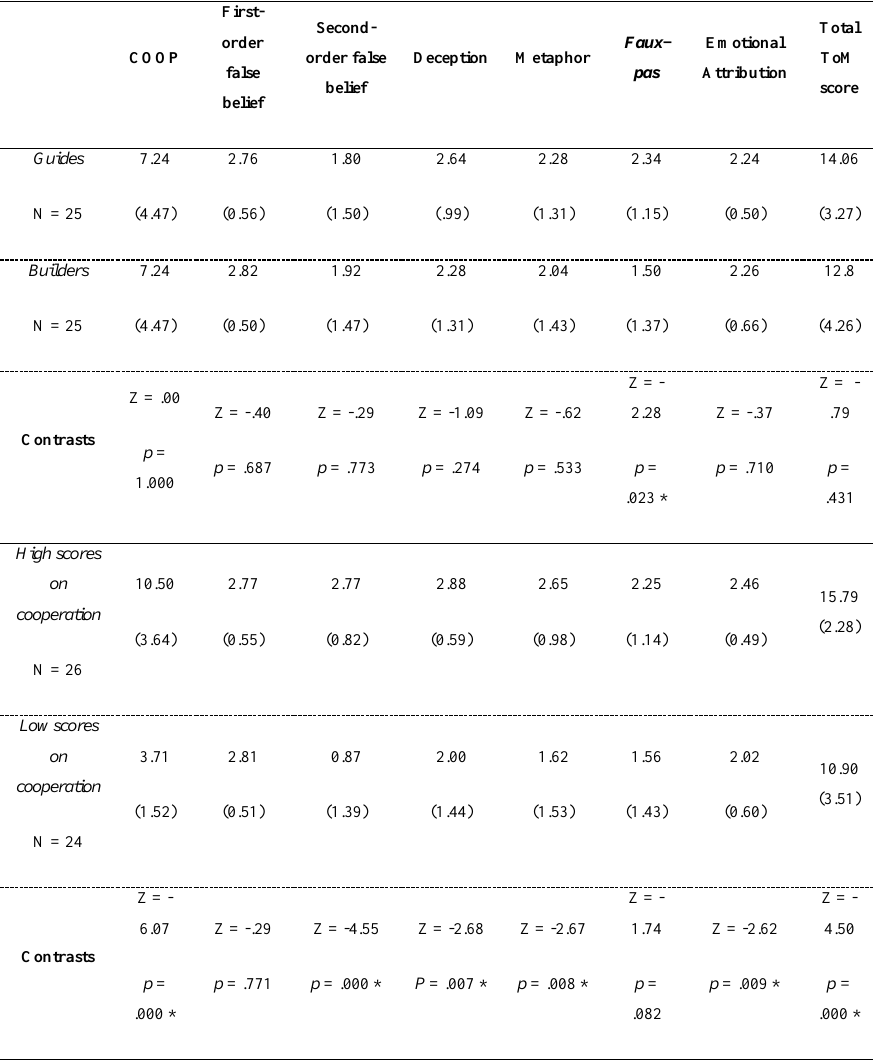
Mean (and standard deviation) in the cooperation and ToM tasks as a function of the role of the participants and the level of success in the cooperative task